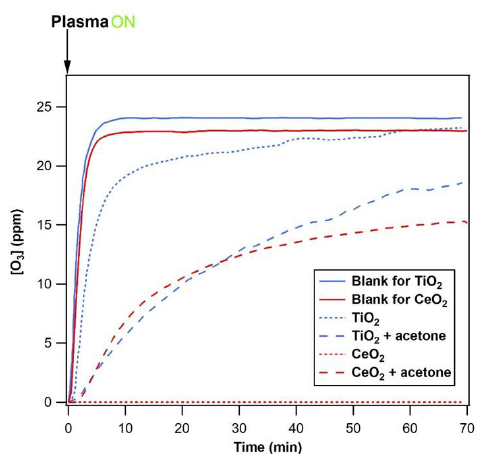
Figure 4. Temporal evolution of ozone concentration at the U-shape reactor outlet under 5 different conditions. (i) Without material in the U-shape reactor, i.e., ozone mixing curve. (ii) With 100 mg fresh CeO 2 . (iii) With 100 mg CeO 2 covered by 2.2 µmol/m 2 of acetone. (iv) With 200 mg fresh TiO 2 . (v) With 200 mg TiO 2 covered by 2.6 µmol/m 2 acetone. Flow rate = 750 mL/min, During the ozonation induced by non-thermal plasma [O 3 ] 0 = 22 ppm for CeO 2 , [O 3 ] 0 = 24 ppm for TiO 2 and acetone is preadsorbed according to the protocol described in the previous adsorption section.